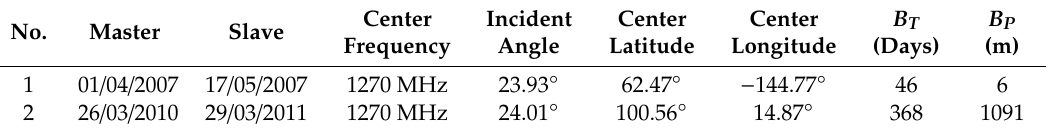
Table 1. Interferometric parameters used in the experiment, where B T stands for temporal baseline and B p stands for perpendicular